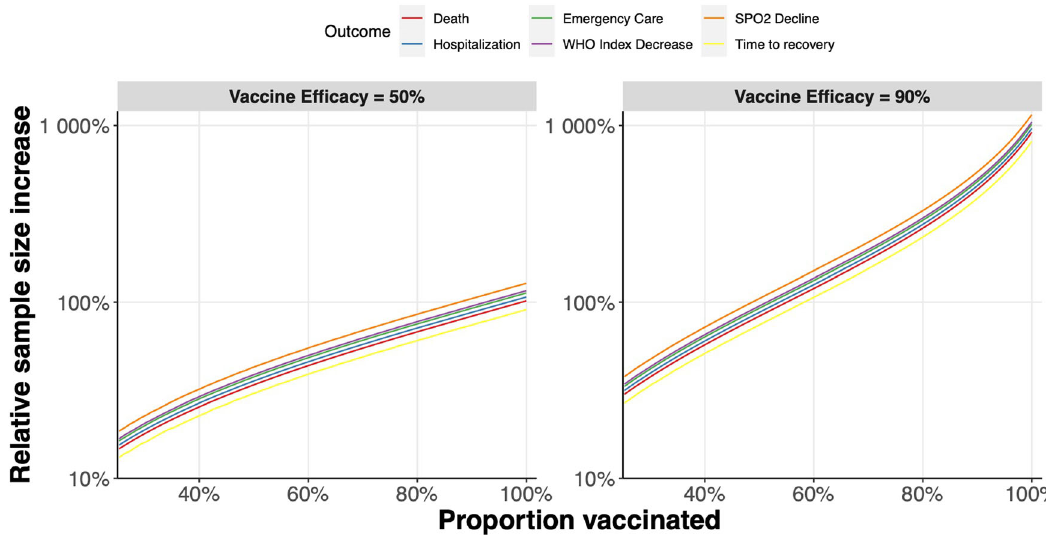
Fig. 1 Sample size necessary for outpatient clinical trials with varied endpoint event rates and vaccine coverage. We assumed background (control) event rates (CER) of 2%, 7·5%, 13%, 16% and 25% for death, hospitalization, emergency care use, a 2-point improvement on the WHO symptom scale and SPO2 decline, respectively. 14-day recovery was assumed to occur 92·5% of the time in the control arm (all but hospitalized). We then calculated the sample size required for 90% power to detect a 30% relative risk reduction (or equivalently, 0·7 hazard ratio in the case of time to recovery) effect at the 2·5% signi fi cance level, assuming zero vaccine coverage 19,20 . The power was then held fi xed at 90% and modi fi ed sample size requirements were calculated, as the background rates changed according to CER(adjusted) = CER*(1-VE*p), where VE is the vaccine ef fi cacy and p is the vaccine coverage in the general population, under the simplifying assumption that VE remains the same for all different outcomes. The increase in sample size relative to zero vaccine coverage is shown in the fi gure for all outcomes.